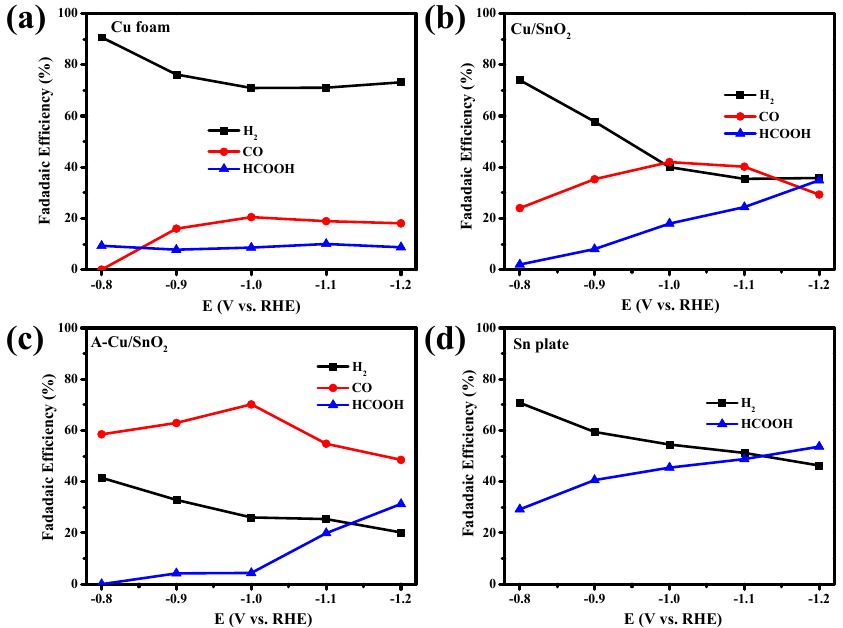
Figure 6. The faradaic efficiency of H 2 , CO and HCOOH on ( a ) Cu foam, ( b ) Cu/SnO 2 , ( c ) A-Cu/SnO 2 and ( d ) Sn plate at various potentials in 0.1 M KHCO 3.